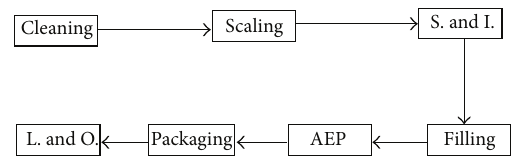
Figure 1: Manufacturing steps of SC used in meat and poultry food in the food